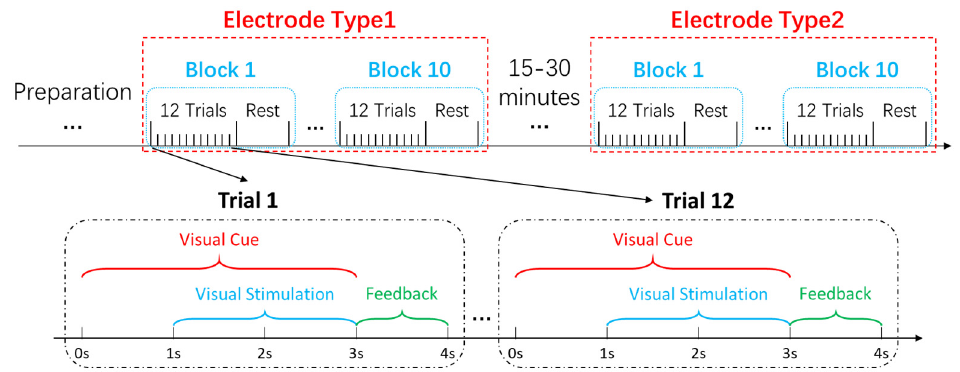
Figure 3. The schematic diagram of the experimental design for each subject.